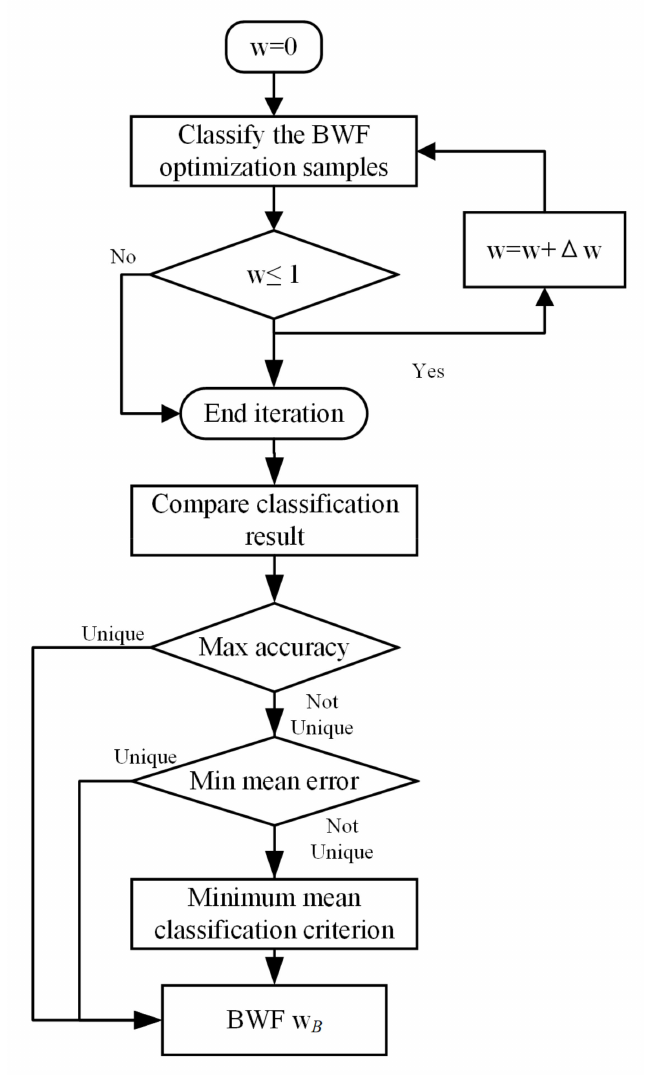
Figure 8. Solution process for balancing weight factor